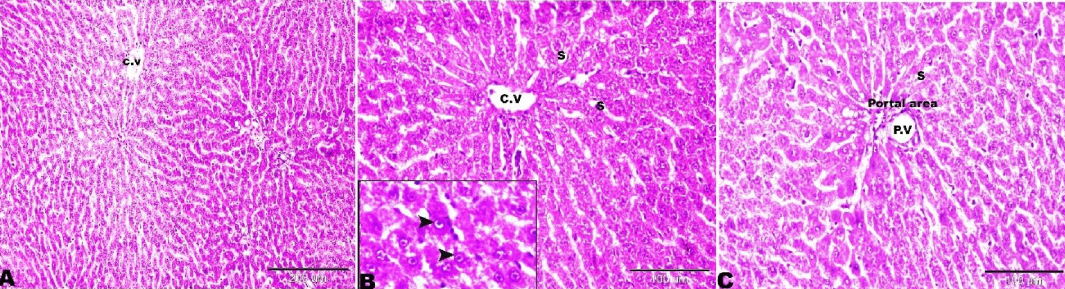
Figure 8. Photomicrograph of the rat liver Group I showed normal histological architectures. ( A ) Intact parenchymal hepatic architecture. ( B ) Normal central vein (C.V), hepatic sinusoids between hepatic lobules (S), hepatocytes (selected square, arrowheads). ( C ) Portal area containing normal portal veins (PV), hepatic artery, and bile duct. H&E stain, the bar size was indicated under pictures.